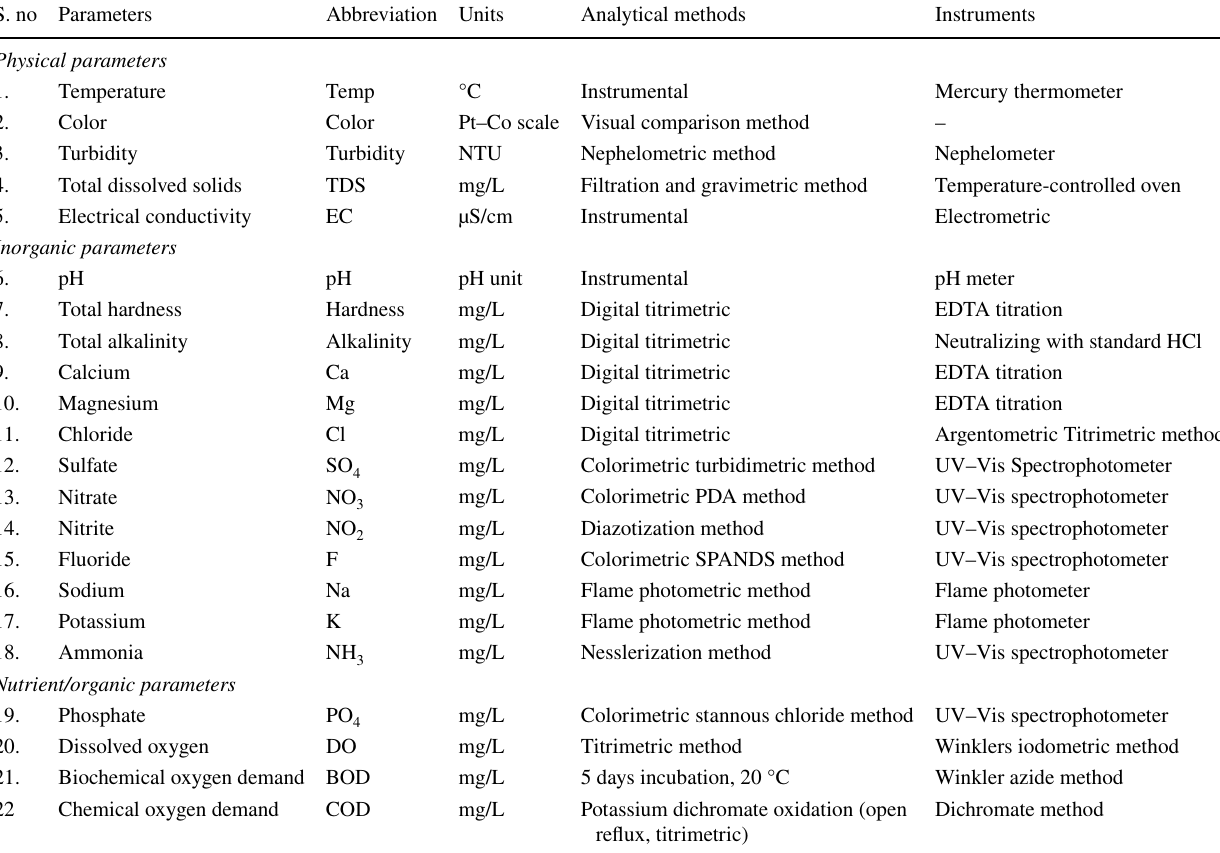
Table 2 Water quality parameters units and analytical methods used S. no